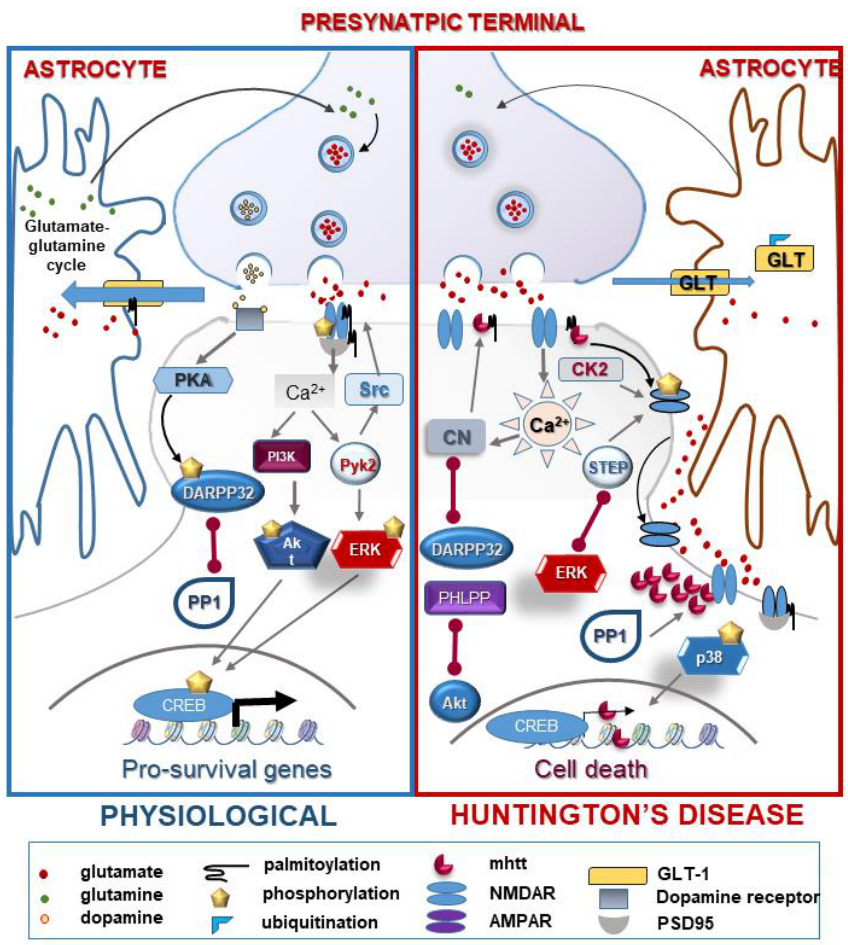
Figure 2. Summary of players in the process of excitotoxicity in HD. The glutamate level increases in the presence of mutant huntingtin. Trafficking of NMDAR and AMPAR from the ER is imbalanced. The activation of extrasynaptic NMDAR is increased, leading to neuronal cell death by the inhibition of ERK, and the activation of the transcription factor CREB. The downregulation of the glial glutamate transporter (GLT-1) results in a defect of its translocation to the plasma membrane. This leads to an increased glutamate level at the synaptic cleft. Arrows represent activation, and red lines, inhibitory processes.